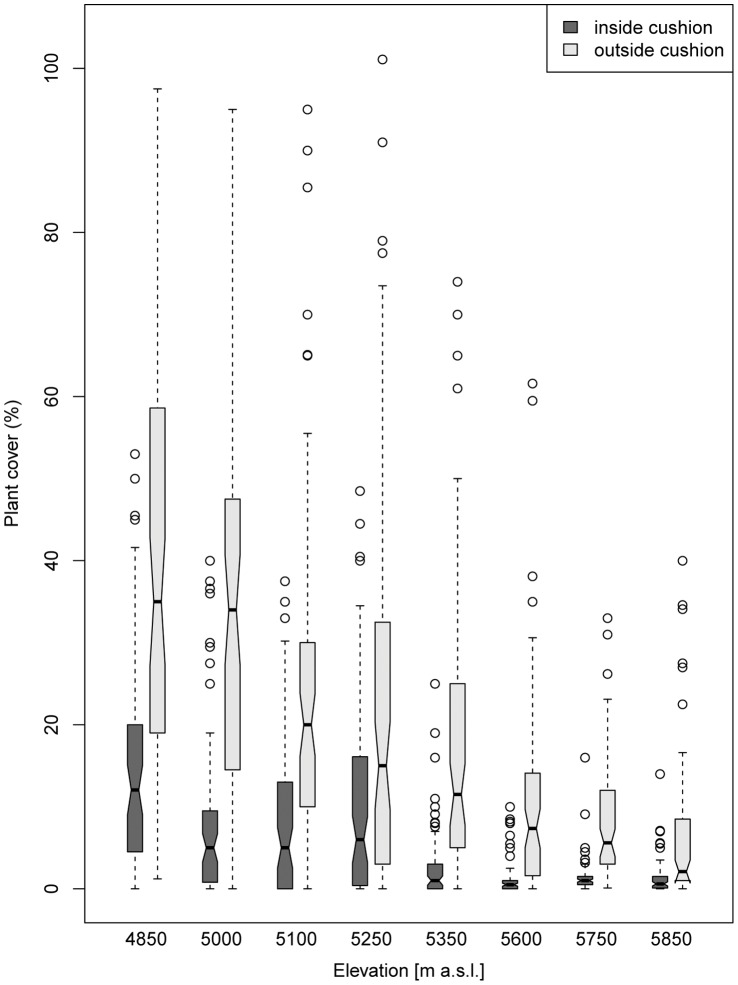
Comparision of total cover of vascular plants growing on the Thylacospermum caespitosum cushions and open areas outside cushions (vegetated area, the rest is bare soil or soil crusts) in Nubra (4850–5250 m) and Tso Moriri (5350–5850 m).The surveyed cushions represented all size classes with a diameter range of 4–132 cm. Boxes represent 25–75% of values, black dots are medians, whiskers are 1.5 interquartile ranges and open dots are outliers. Notches in the boxes indicate the significance of between-group differences: if notches of two groups do not overlap this is strong evidence that these groups differ significantly.